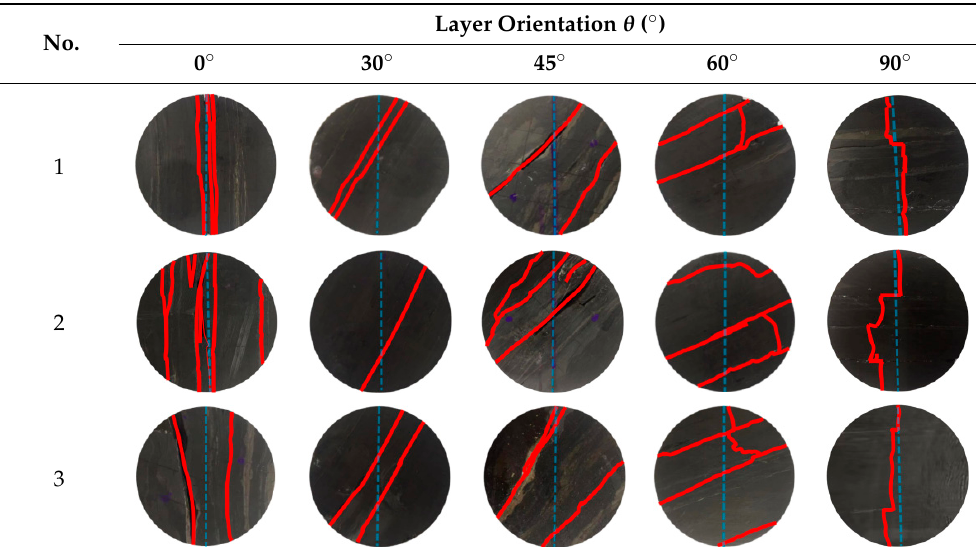
Figure 9. Splitting modulus of samples with different layer orientations.